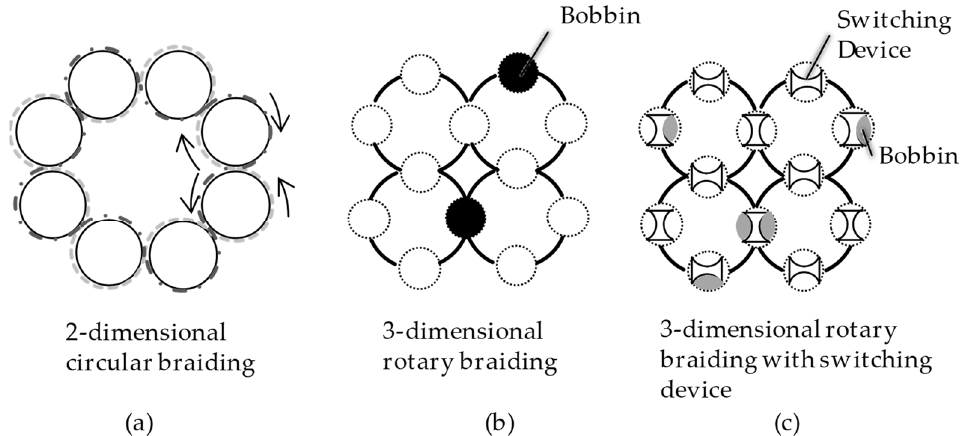
Figure 2. Bobbin movements from ( a ) 2D circular braiding, ( b ) 3D rotary braiding, and ( c ) 3D rotary braiding with switching devices.